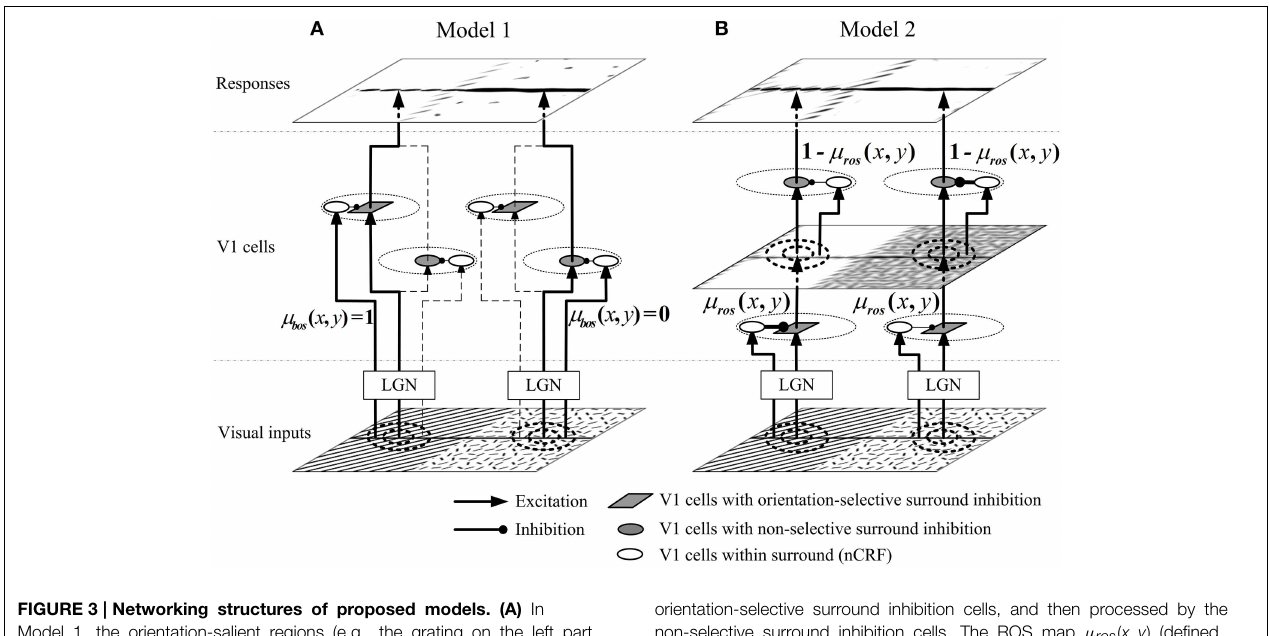
FIGURE 3 | Networking structures of proposed models. (A) In Model 1, the orientation-salient regions (e.g., the grating on the left part of visual inputs, where µ bos ( x , y ) = 1 ) is only processed by the V1 cells with orientation-selective surround inhibition; while the non-orientation-salient regions region (e.g., the random bar filled region on the right part of visual inputs, where µ bos ( x , y ) = 0 ) is only processed by the V1 cells with non-selective surround inhibition. V1 cells on the branches of dashed lines are not selectively activated. (B) In Model 2, the input stimulus at each spatial location is first processed by the